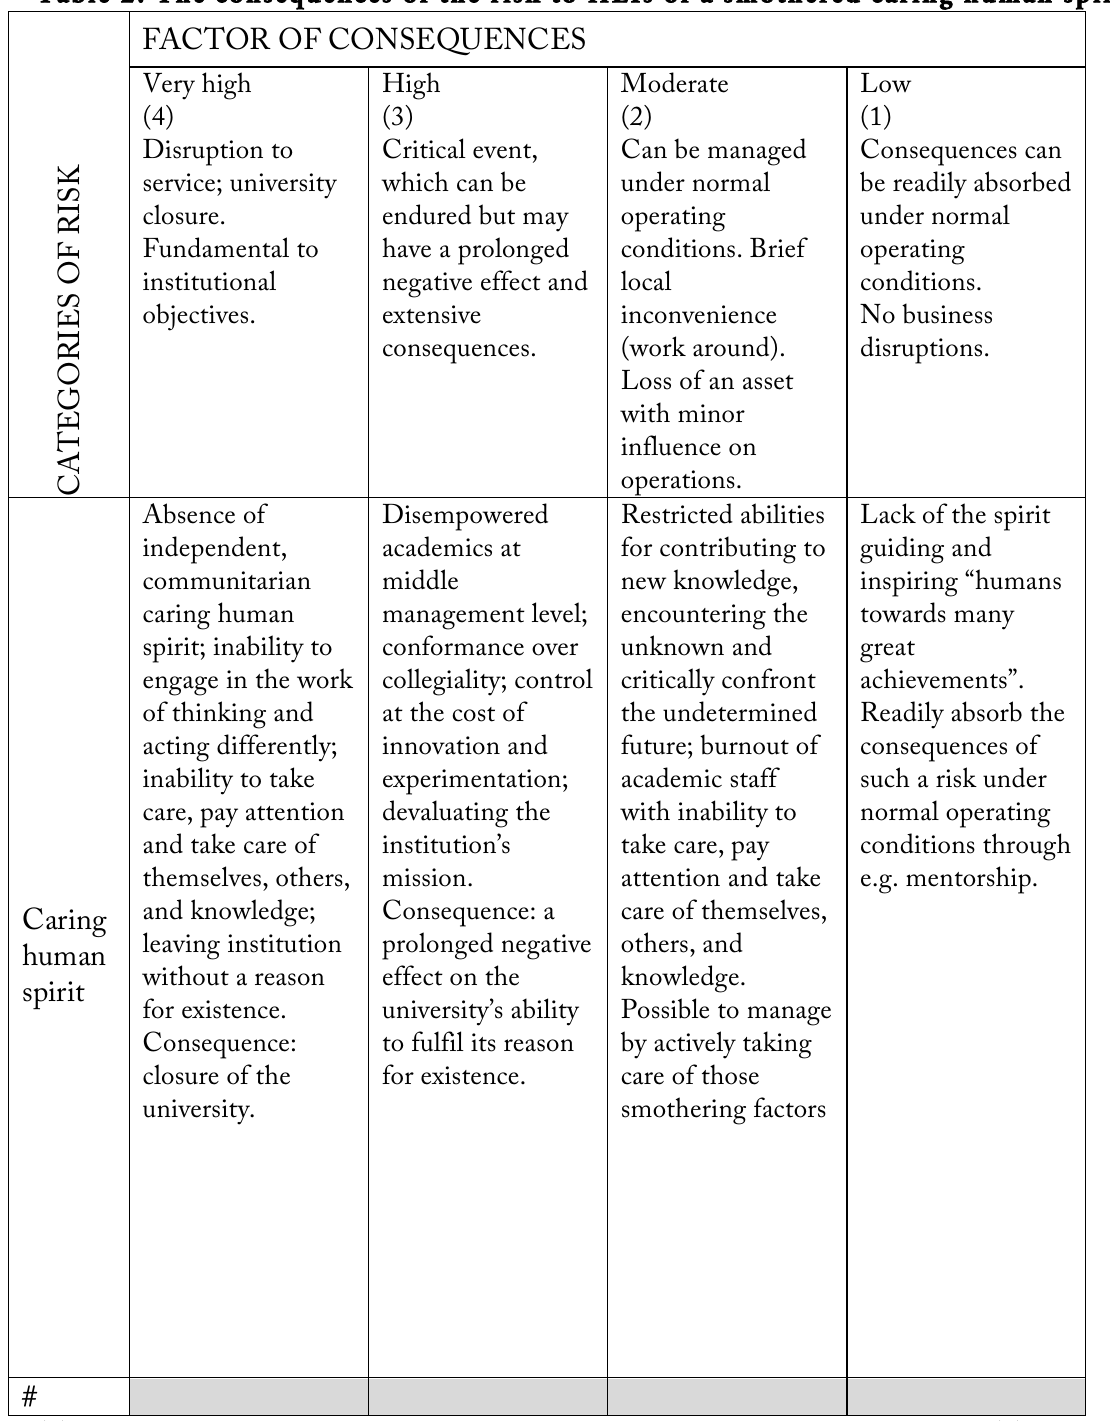
Table 2: The consequences of the risk to HEIs of a smothered caring human spirit